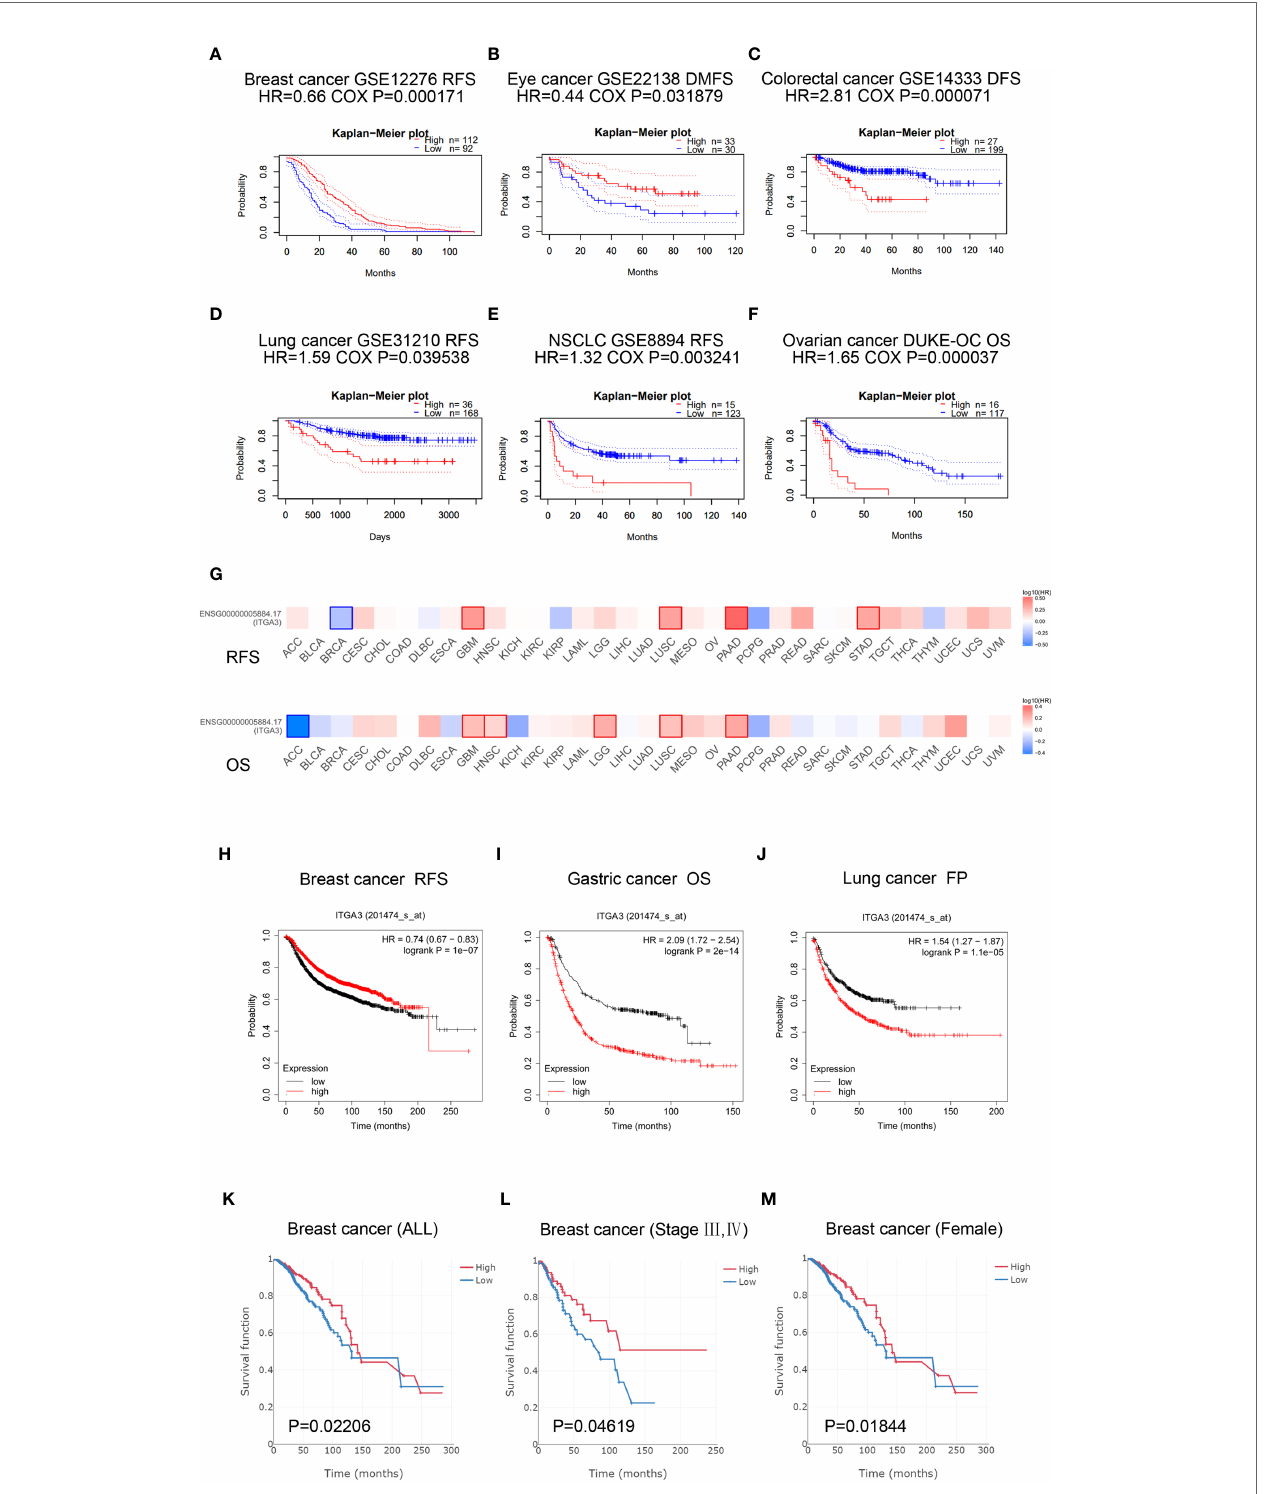
FIGURE 4 | ITGA3 is associated with survival outcome. (A – F) Correlation between ITGA3 and prognosis of various types of cancer in the PrognoScan. (G) Survival map of ITGA3 in pan-carcinoma. (H – J) Kaplan – Meier curves comparing the high and low expression of ITGA3 in breast cancer (RFS), gastric cancer (OS), lung cancer (FP). (K – M) The expression of ITGA3 was signi fi cant for the overall (K) , stage III, IV (L) and female (M) of breast cancer patients ’ OS. OS, overall survival; RFS, relapse free survival; DMFS, distant metastasis free survival; FP, fi rst progression. Logrank P-value <0.05 was considered as statistically signi fi